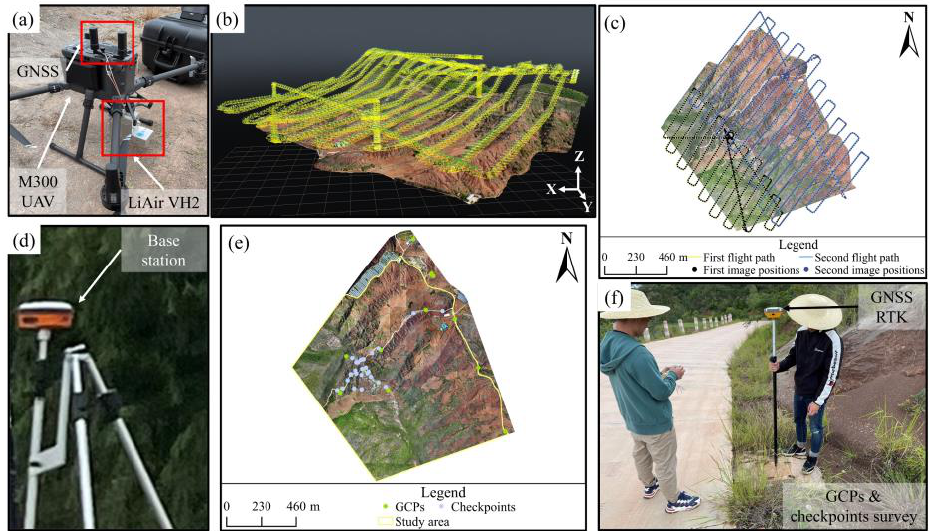
Table 1. The UAV flight platform, LiDAR system, and digital camera parameters. Figure 2. ( a ) The LiAir VH2 LiDAR system, ( b ) the UAV flight trajectory, ( c ) the ground-based flight route, ( d ) GNSS base station, ( e ) GCPs and checkpoints layout, and ( f ) GNSS measurements. Table 2. The UAV flight parameters and collected data information